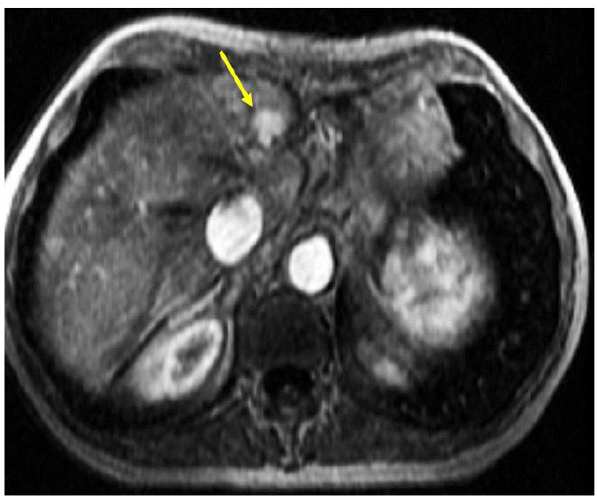
Figure 1. MRI of the abdomen. Contrast-enhanced MRI of the abdomen showed enhancing focal lesion in the lateral segment of the left hepatic lobe (segment